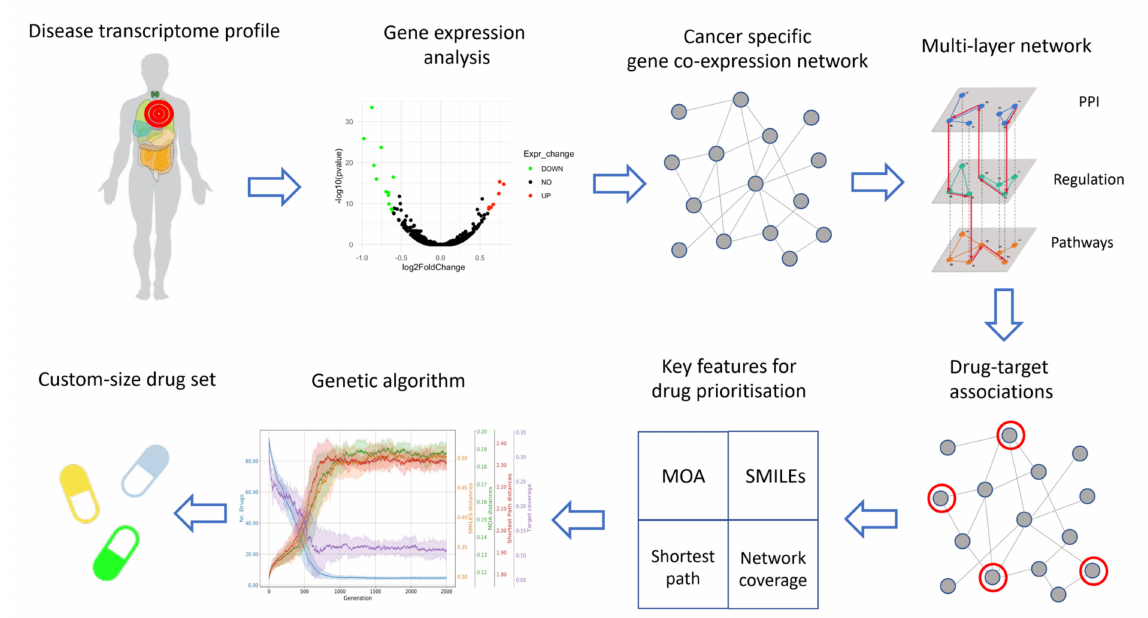
Figure 1. Computational workflow for the detection of drug combinations strategy for drug